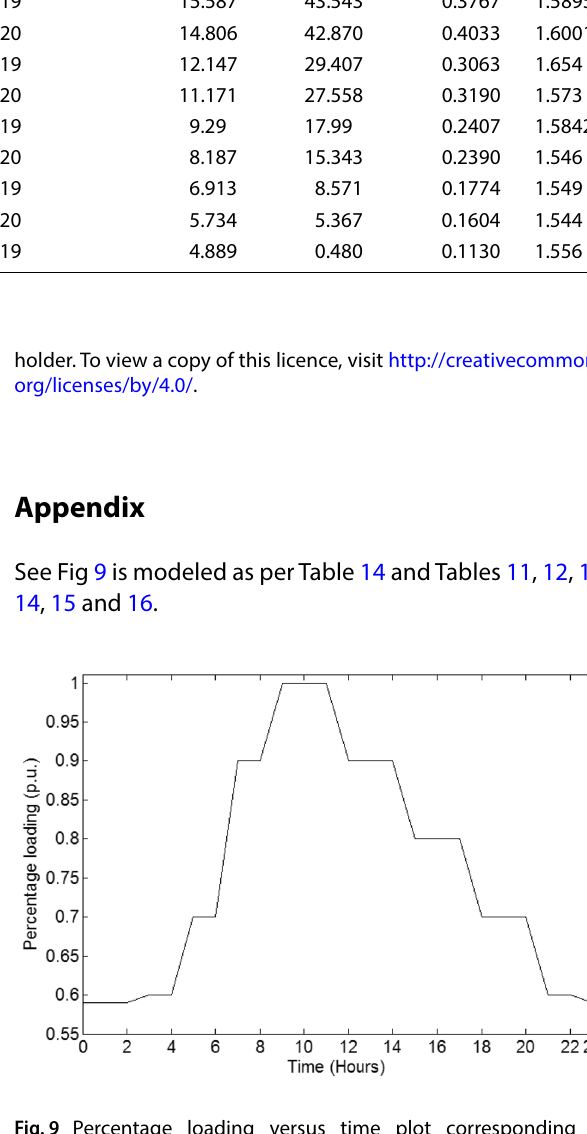
Fig. 9 Percentage loading versus time plot corresponding to Table 14